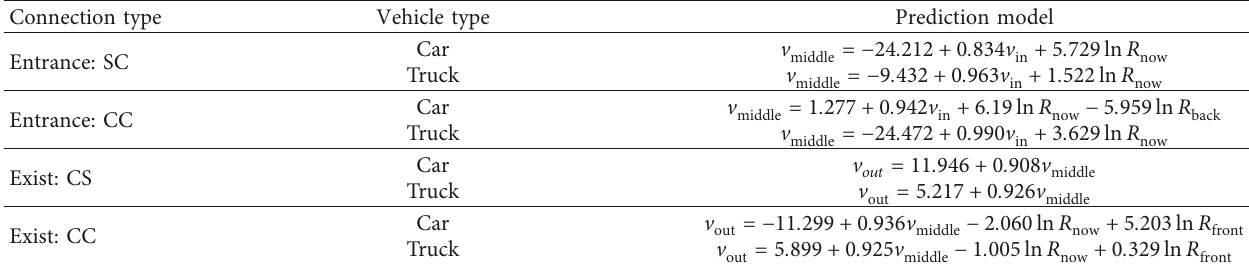
Table 8: Operating speed prediction model for plane curve section.